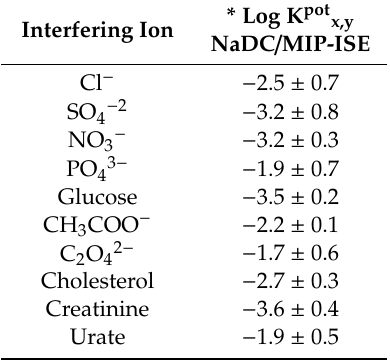
Table 2. Potentiometric selectivity coe ffi cients, Log K pot x,y of the proposed screen-printed ISEs.